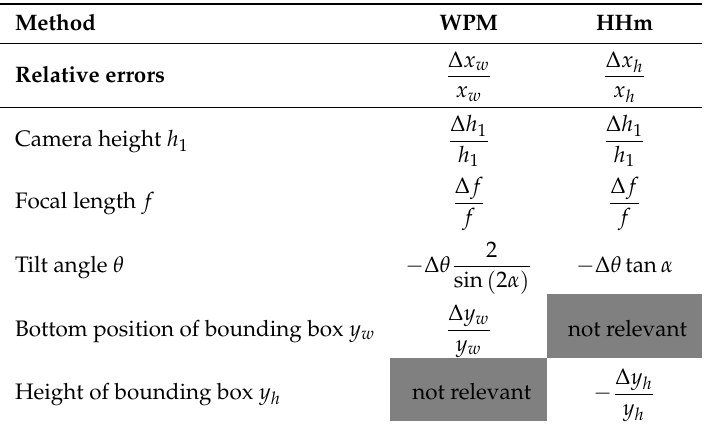
Table 1. Approximate relative errors with respect to the different parameters in the distance estimation formulae (4)–(5) derived from sensitivity analysis. We assume that the tilt angle θ is small and ∂ u / ∂ v ≈ ∆ u / ∆ v for all parameters u and v